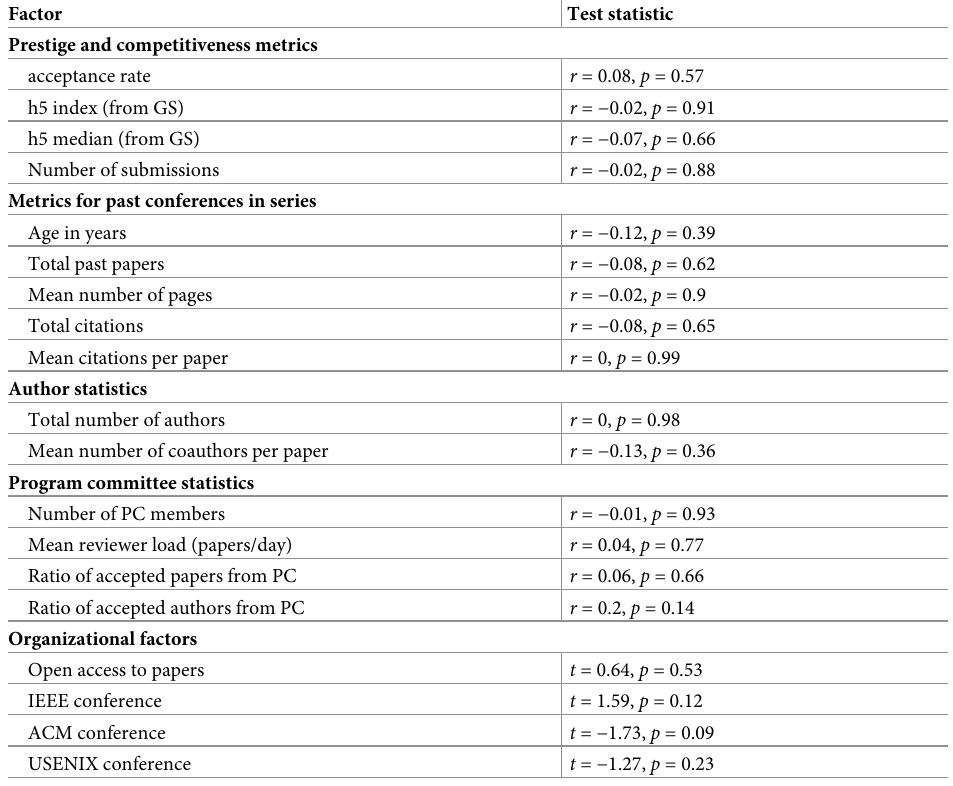
Table 5. Comparisons between conference FAR and additional conference